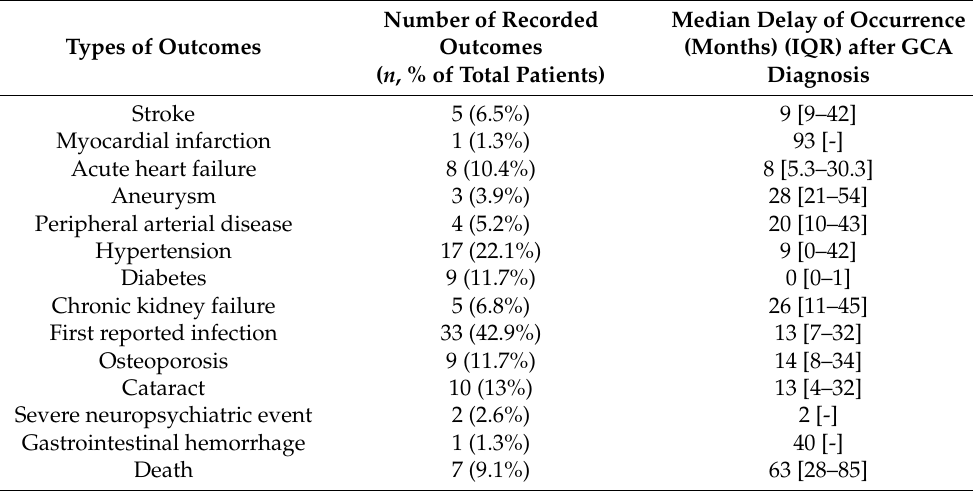
Table 2. Description of 114 severe outcomes and their mean delay of occurrence in the 77 patients with giant cell